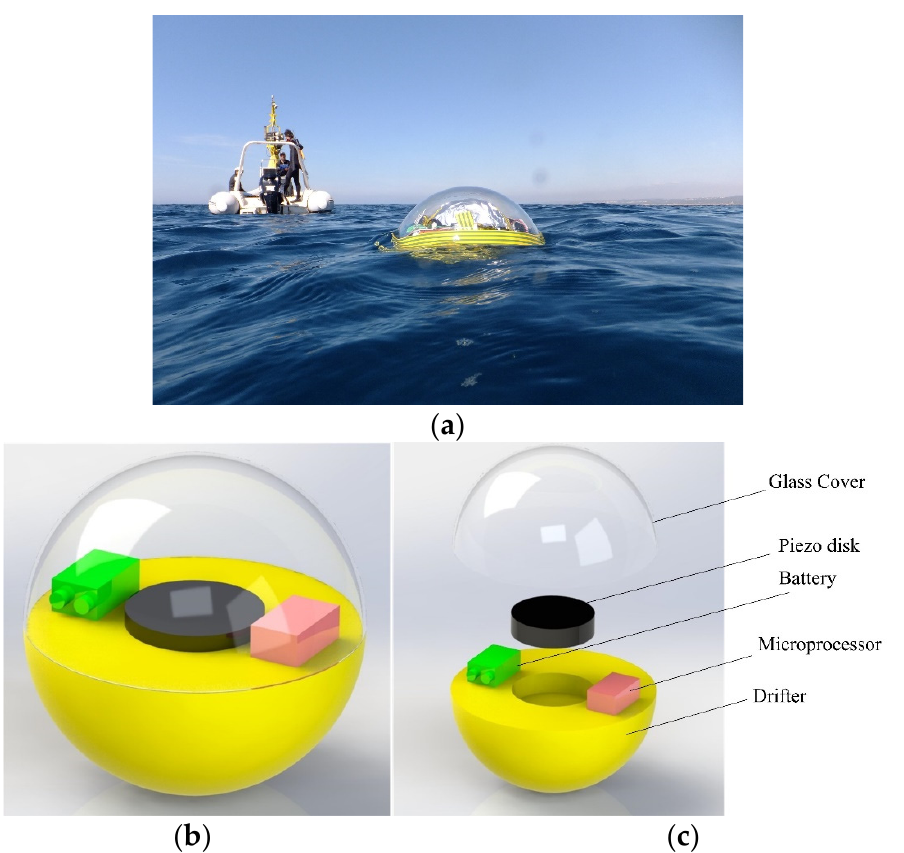
Figure 2. ( a ) An example of oceanic drifters by Carandell et al. [33] ( b ) Proposed drifter-based self-powered piezoelectric sensor for ocean wave measurement; ( c ) Sensor’s components (Glass cover, piezo disk, battery, microprocessor, and drifter).